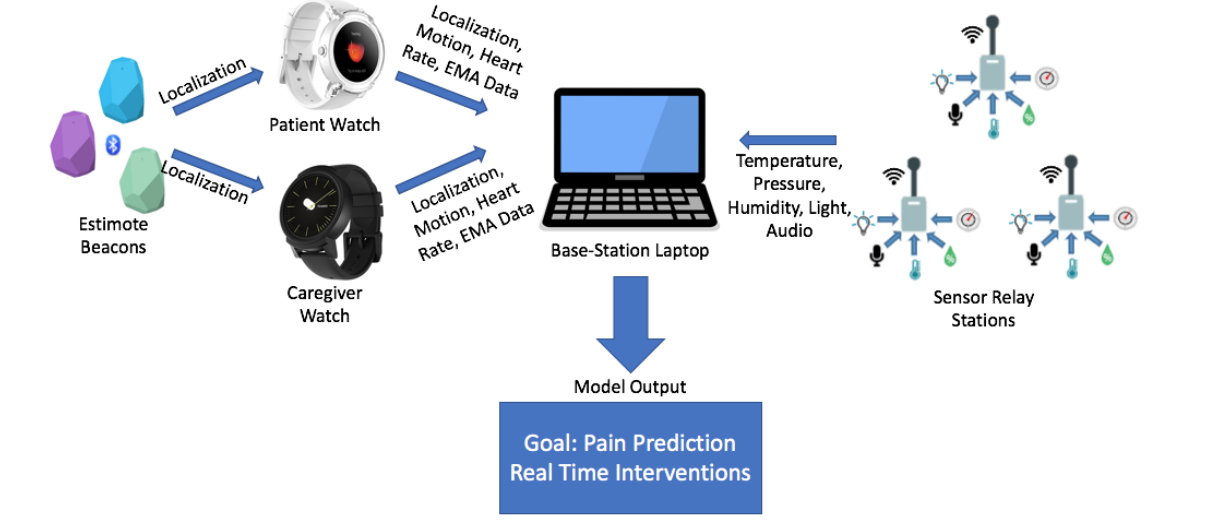
Figure 4. The Behavioral and Environmental Sensing and Intervention for Cancer system architecture for passive data collection: (left to right) Bluetooth Estimote beacons, patient and caregiver smart watches, base station, and sensor relay stations. EMA: ecological momentary assessment.